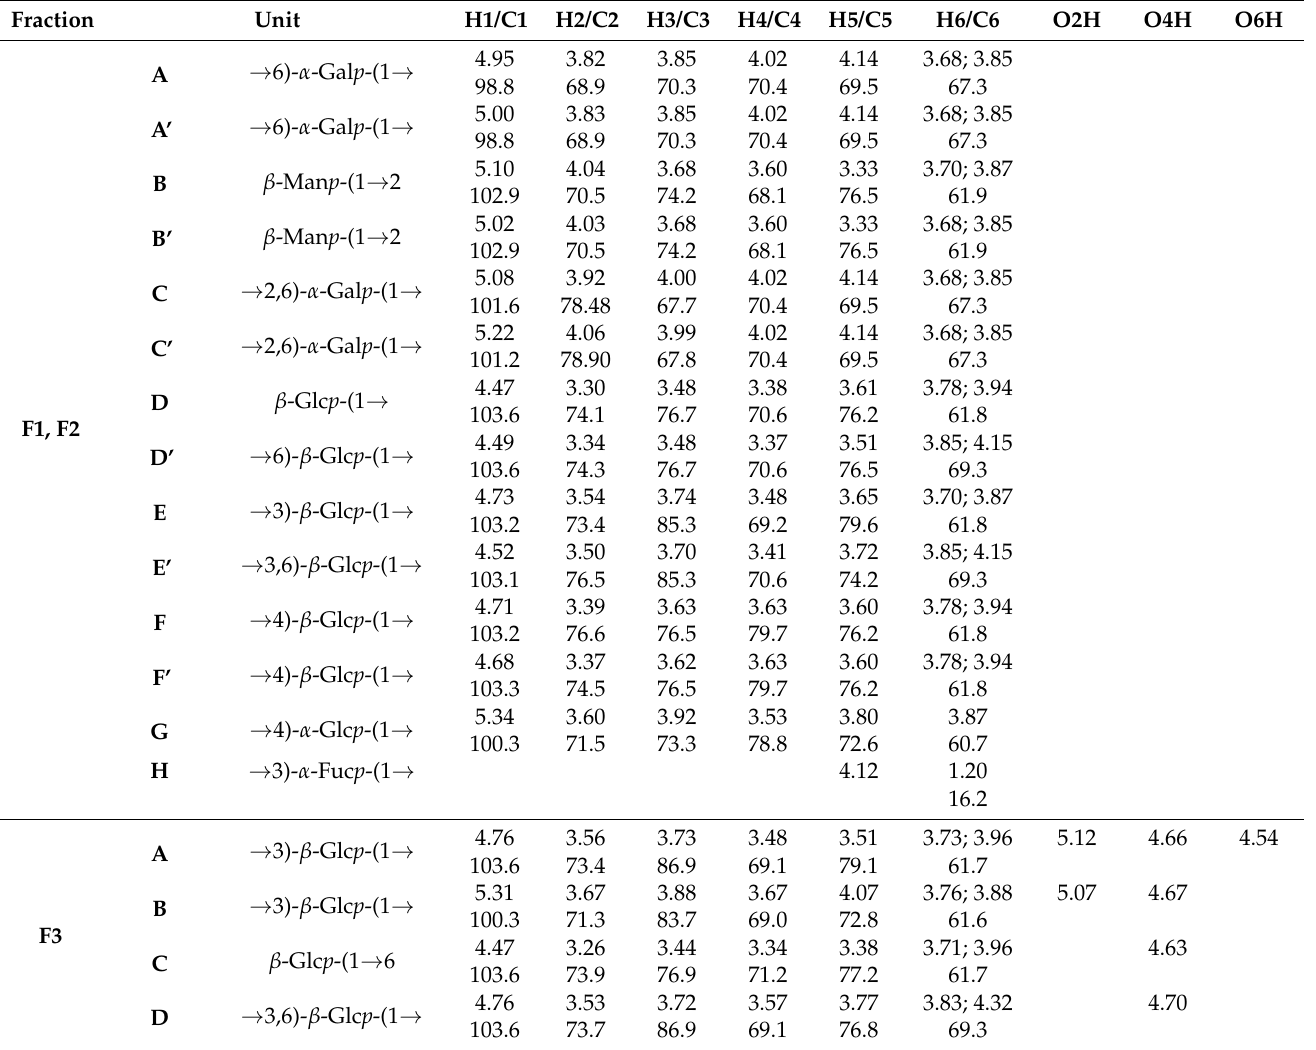
Table 6. The assignment of proton and carbon signals (ppm) of the main sugar units for the fractions F1 , F2 , and F3